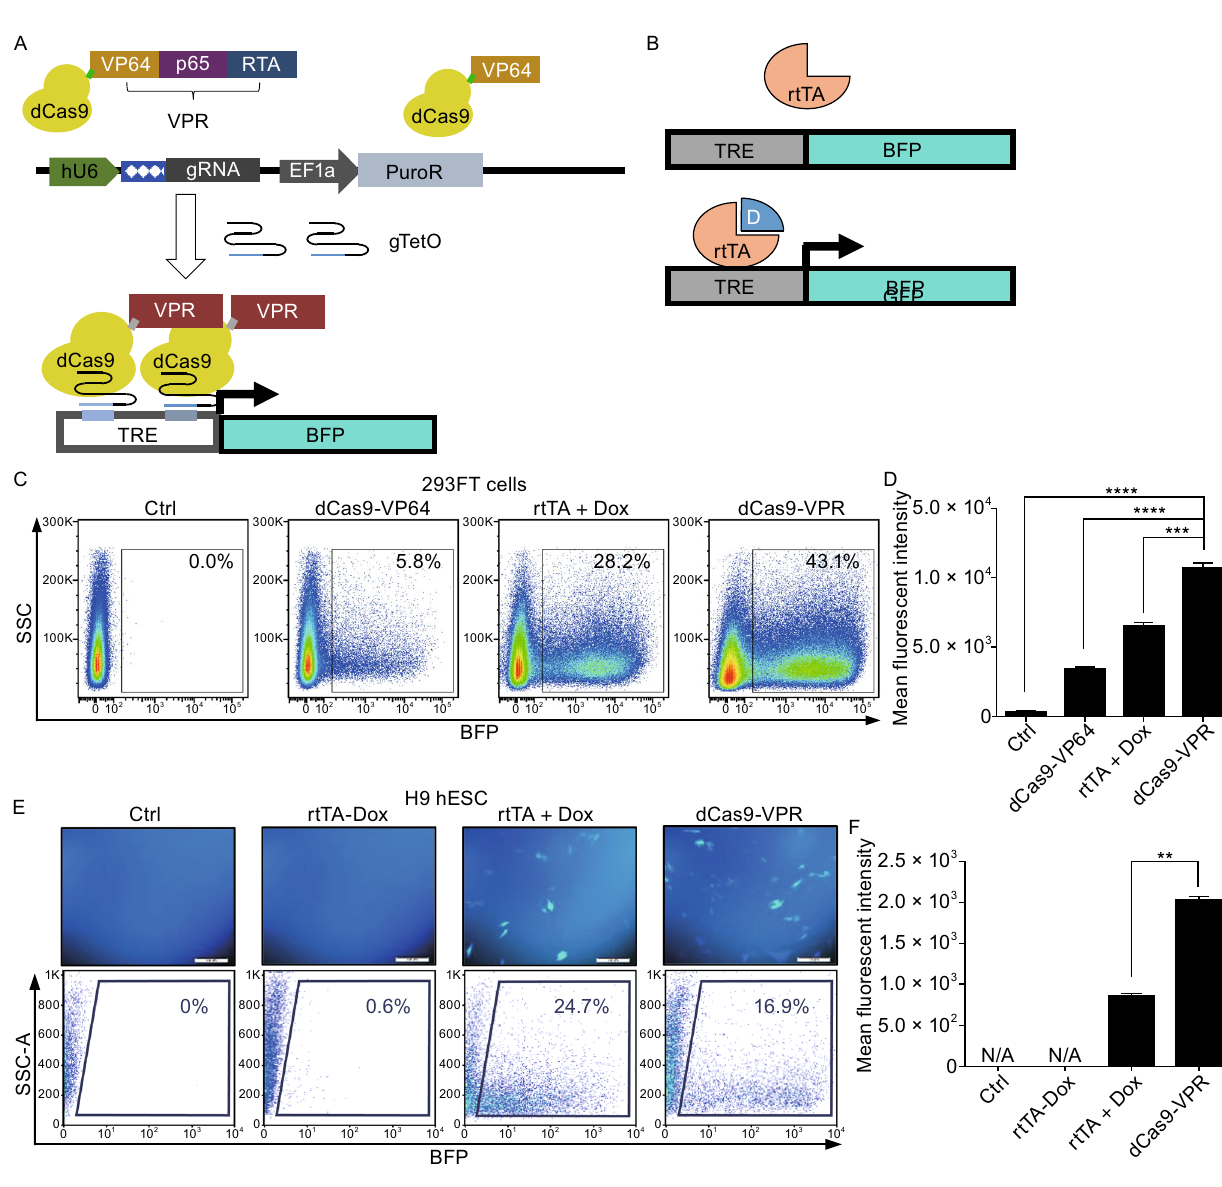
Figure 1. The dCas9-VPR system leads to robust transcription activation in human cell lines. (A) Schematic diagram of the gRNA guided dCas9-VPR gene activation system that consists of two parts: one plasmid contains dCas9-VPR driven by a CAG promoter; another plasmid contains gRNA targeting the promoter of the gene of interest driven by the human U6 promoter, in this case gTetO, and a PuroR selection cassette driven by an EF1 α promoter. Upon co-transfection of the two plasmids, dCas9-VPR can activate the BFP transcription downstream of the TRE promoter. (B) Tet-On system: rtTA protein can bind to the TRE promoter and drive expression of the down-stream BFP gene in the presence of Dox. (C) 293FT cells were transfected with the reporter plasmid containing BFP driven by the TRE promoter. They were either co-transfected with dCas9-VPR or dCas9-VP64 and gTetO plasmids, or with the CAG-rtTA plasmid. Dox was added immediately after transfection. Cells were harvested 2 days after transfection and the fl uorescence was analyzed using fl ow cytometry. (D) Bar graph quanti fi cation of mean fl uorescent intensity analyzed using the FlowJo software v7.6.1. *** P < 0.001, **** P < 0.0001, n = 3. (E) H9 hESCs were electroporated with either rtTA or dCas9-VPR + gTetO plasmids together with the TRE-BFP plasmid. Dox was added immediately after electroporation. Cells were harvested 3 days after electroporation and analyzed using fl ow cytometry. (F) Bar graph quanti fi cation of the mean fl uorescent intensity analyzed using the FlowJo software v7.6.1. N/A, not applicable. ** P < 0.01, n =